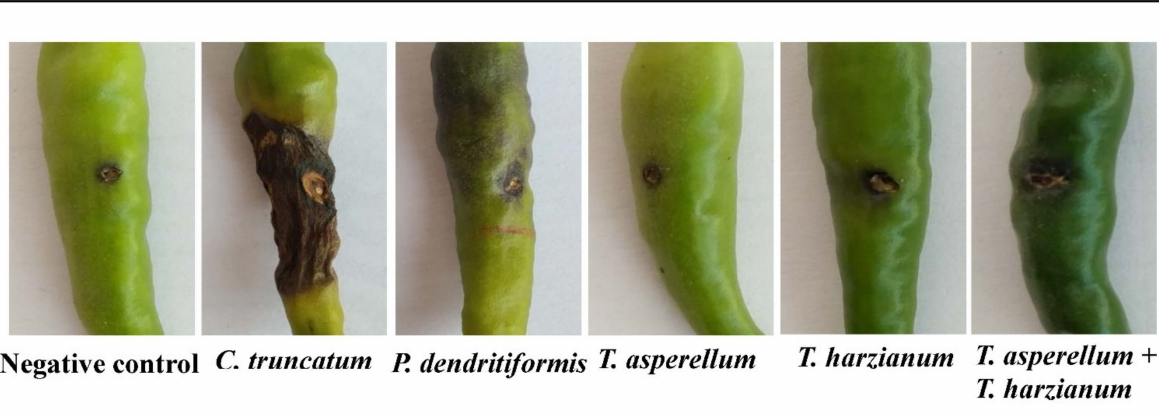
Figure 7. Induced systemic resistance by suppression of anthracnose disease development in chilli fruits treated by P. dendritiformis , T. asperellum , T. harzianum, and T. asperellum + T. harzianum in challenged and C. truncatum -infected samples under greenhouse conditions. The disease lesion development was recorded after ten days post-inoculation of C. truncatum . Treatment with bioagents on inoculation of C. truncatum showing reduced lesion development as compared to C. truncatum inoculation and control.